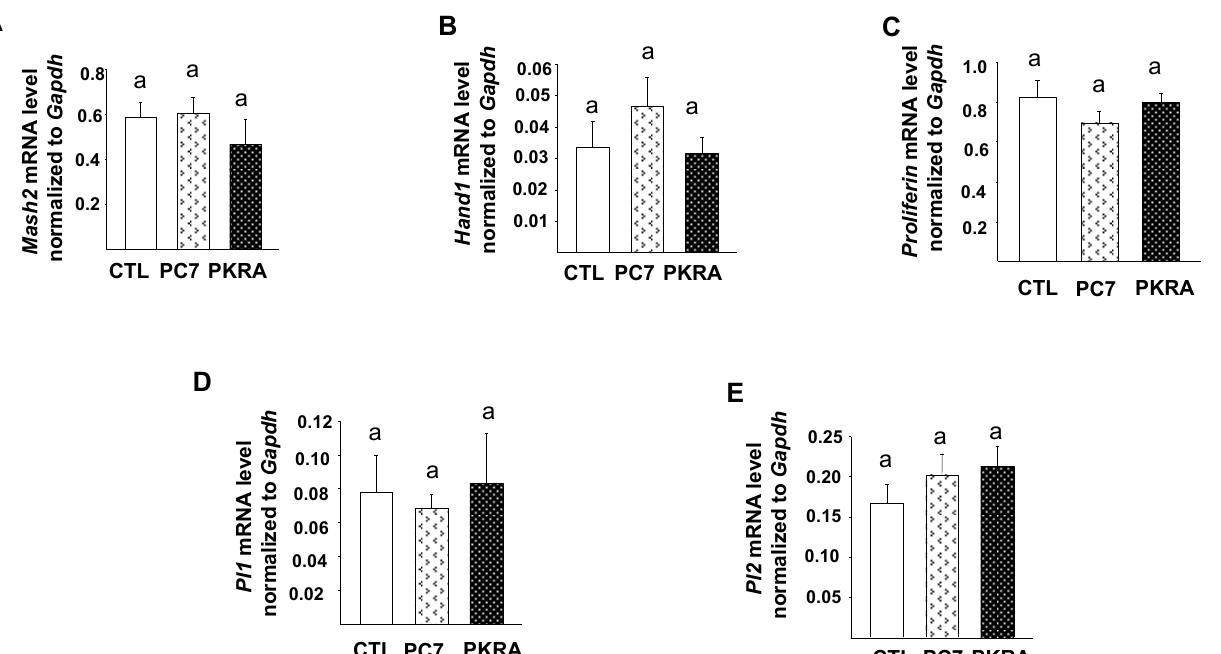
Figure 5. Effects of prokineticin antagonists’ treatment on key placental development genes expression. ( A – E ) depict comparisons of Mash2 , Hand1 , Proliferin and Placental lactogen1 and 2 mRNA levels, respectively in placentas of collected from CTL; PC7 and PKRA treated mice. Gapdh was used to standardize for mRNA expression. Data are represented as mean ± SEM. p < 0.05. Bars with different letters are significantly different from each other.